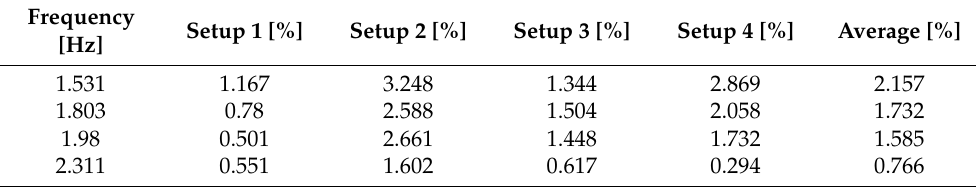
Table 3. Identified damping ratios [%] for each setup and average values for the modes at resonance